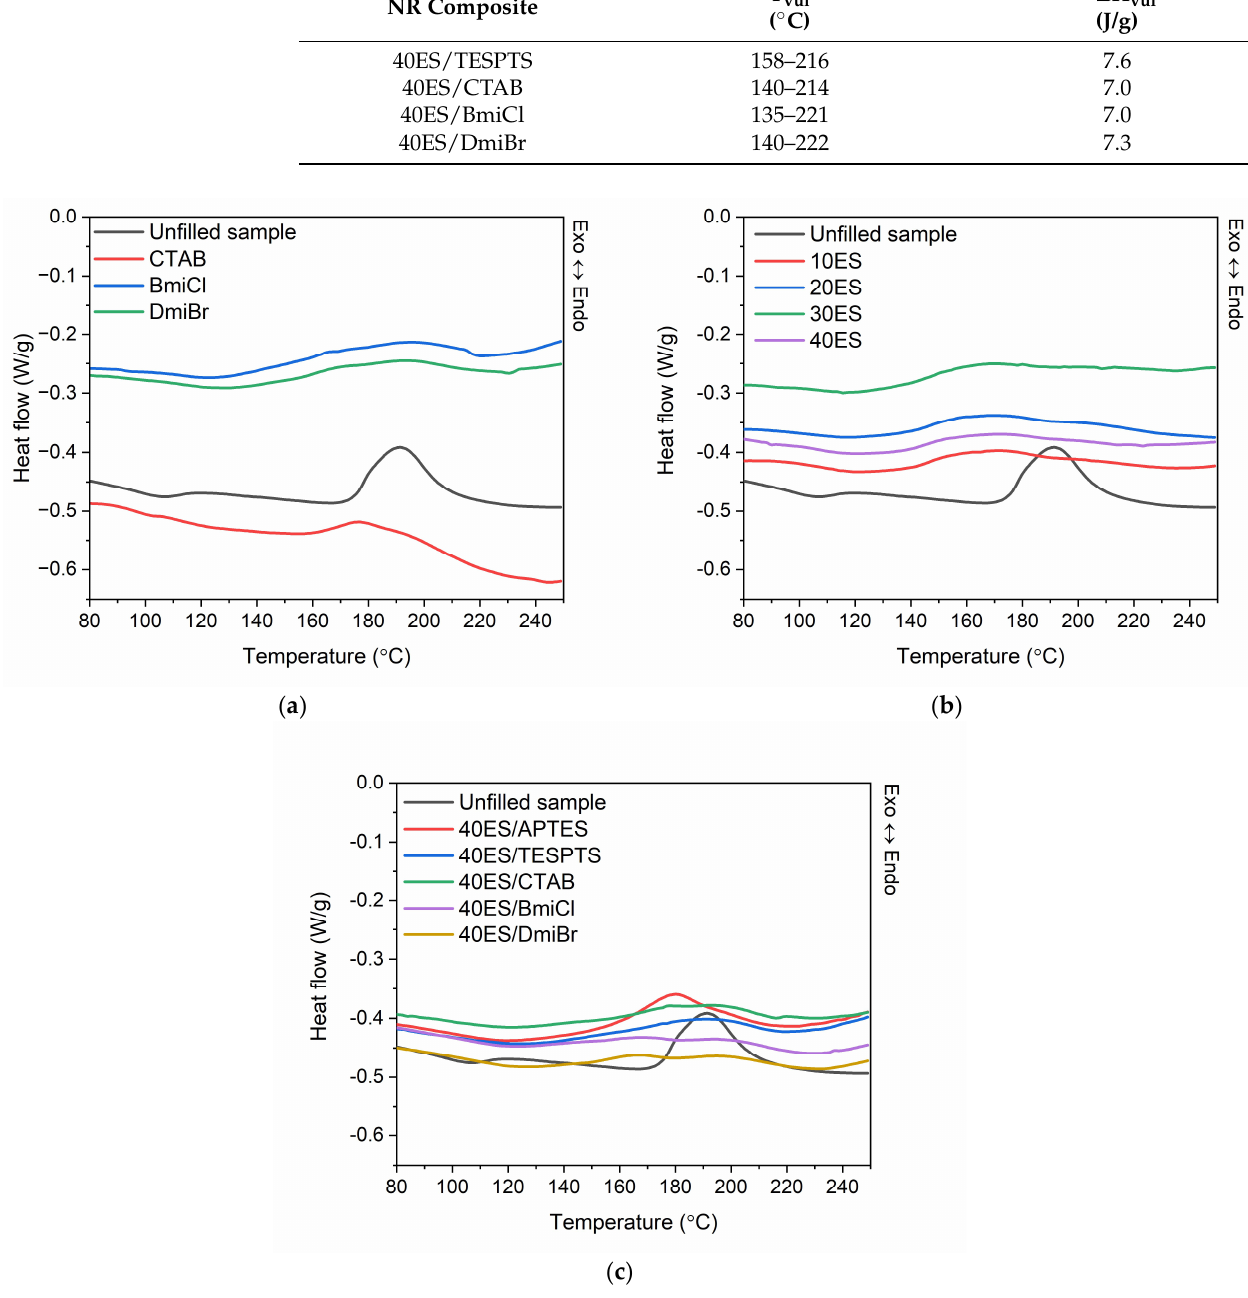
Figure 4. DSC curves for vulcanization of NR compounds: ( a ) without filler; ( b ) with addition of eggshells; ( c ) with addition of eggshells, silanes, CTAB, and ILs. Vulcanization is an exothermic process which can be identified as a peak on DSC curve and that can be integrated by determining the amount of heat released in this process. Regarding DSC curve of the unfilled NR compound, it was observed that the vulcanization proceeded in a temperature range of 174–210 ◦ C (Figure 4). After starting at about 174 ◦ C, vulcanization proceeded intensively with the enthalpy of approximately 13.8 J/g. Applying CTAB and ILs in the unfilled NR compounds lowered the onset vulcanization temperature by approximately 30 ◦ C and so had a significant influence on this process. Thus, DSC results confirmed the beneficial, catalytic impact of these